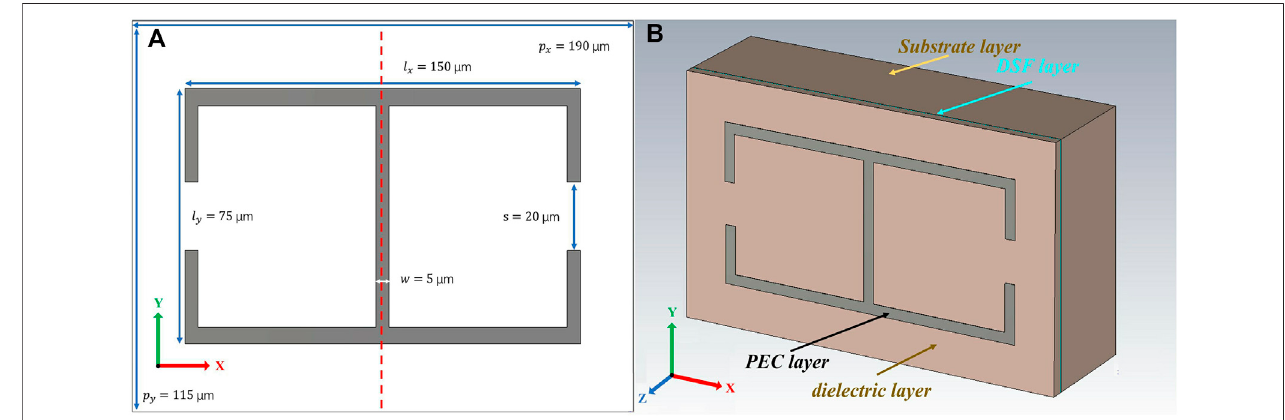
FIGURE 1 | (A) Front view of the toroidal dipole structure. (B) The proposed tunable toroidal dipole made of a metallic pattern (perfect electric conductor (PEC)) layer, a dielectric layer, a Dirac semimetal fi lm (DSF), and a substrate layer.